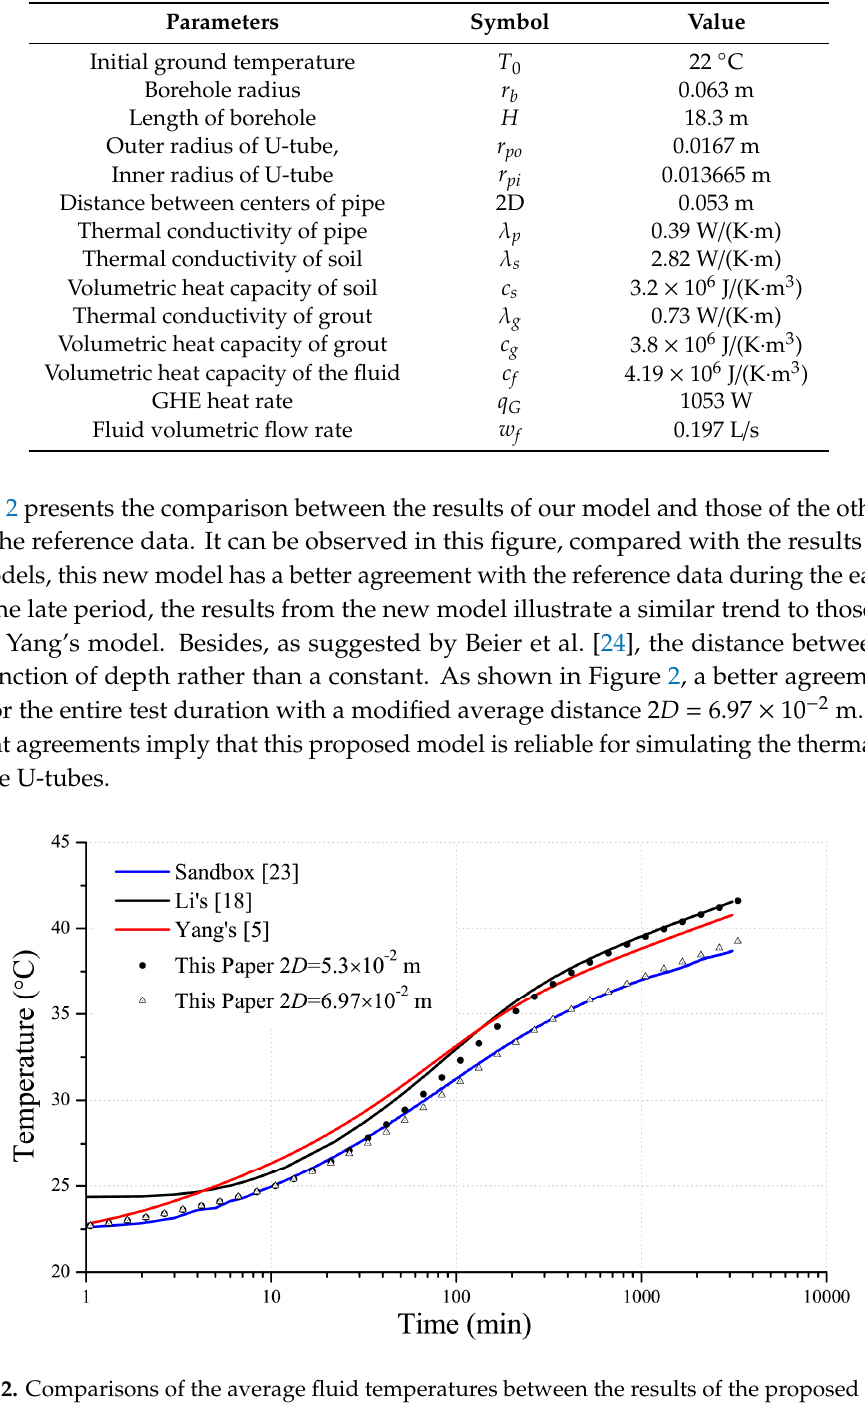
Table 1. Values of the parameters used for validating the proposed model [23].